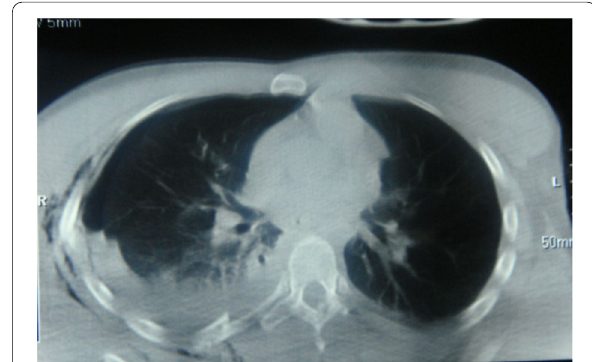
Fig. 11 CT scan of the chest in case 2 showing right-side hemopneumothorax, rib fractures, and surgical emphysema